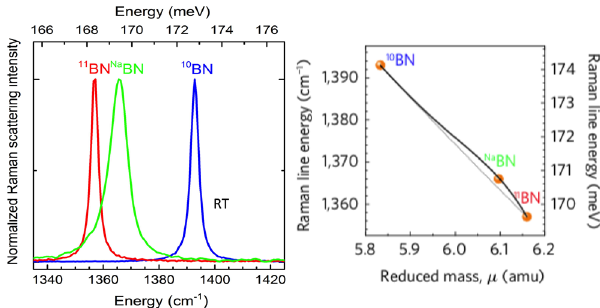
Figure 9: (a) Raman features obtained at room temperature for BN grown with natural boron Nat B (green), 11 B(red) and 10 B(blue ) monoisotopically puri fi ed boron. (b) Plot of the energies measured for the high frequency Raman active phonon versus the reverse of the reduced mass µ (1/µ = 1/m N + 1/m B where m N and m B are the nitrogen and atomic masses repectively). After Figure 1b,c of reference